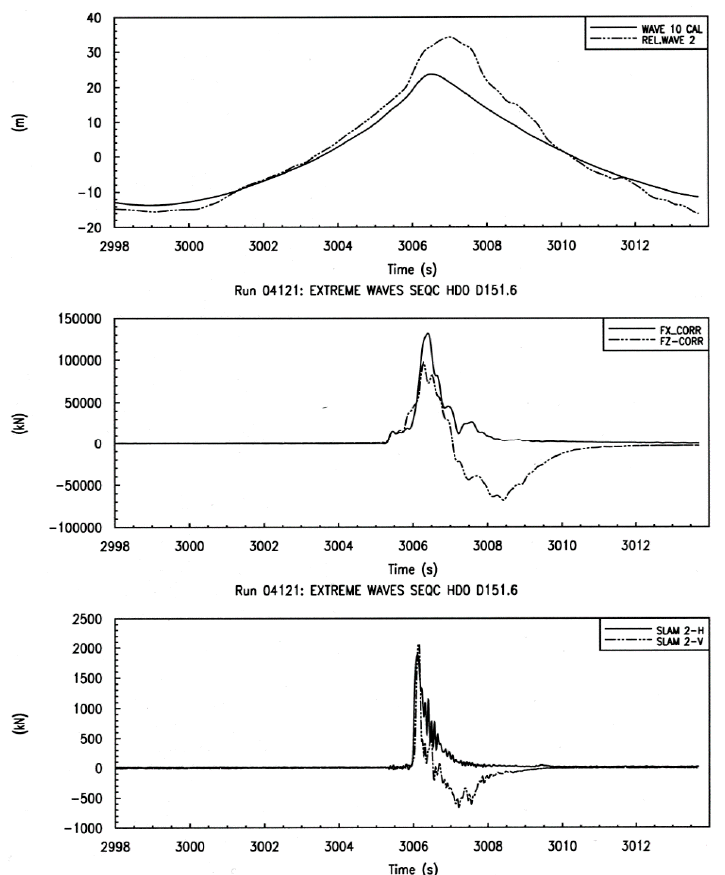
Figure 2. Wave impact event from [8]: ( top ) incident (undisturbed) and disturbed wave elevation at deck front. ( middle ): Global horizontal and vertical deck force; and ( bottom ) local horizontal and vertical slamming force.